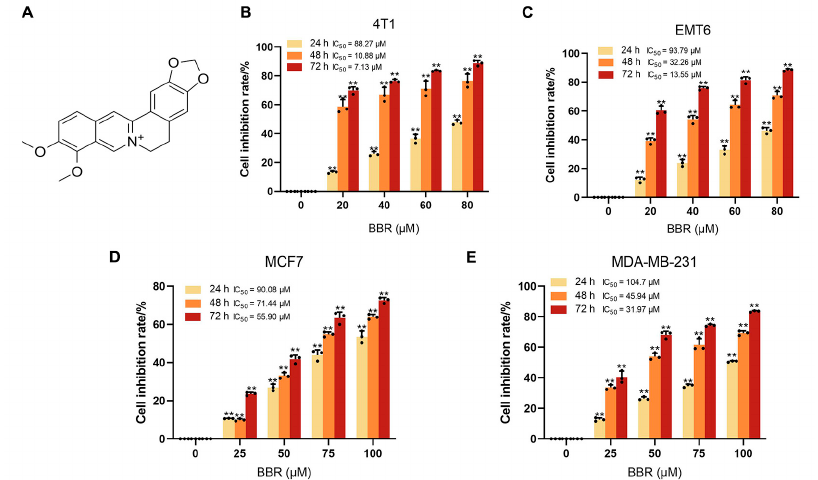
Figure 1. Inhibitory effects of BBR on BRCA cells. The chemical structure of BBR ( A ); 4T1 ( B ), EMT6 ( C ), MCF7 ( D ), and MDA-MB-231 ( E ) cells were treated with various concentrations of BBR for 24, 48, and 72 h, respectively. ** p < 0.01 vs. control. Data represent the means ± SD of three independent experiments.